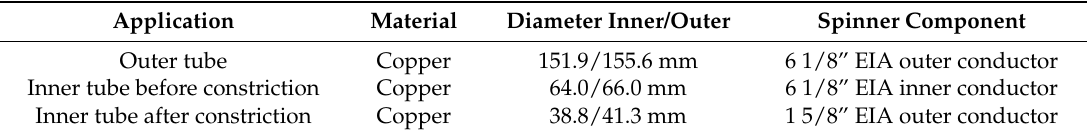
Table 1. Features of the tubes of the coaxial erosion cell according to the data sheet of the